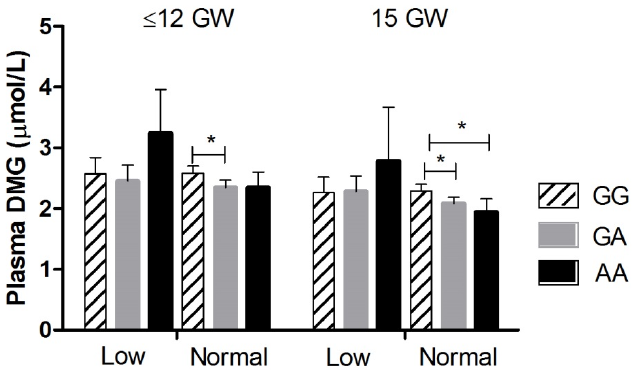
Figure 2. Plasma dimethylglycine according to BHMT c.716G>A genotype and folate status in early pregnancy. G: guanosine; A: adenosine; GW: Gestational weeks. Low: possibly deficient (plasma folate ≤ 13.4 nmol/L). Normal: normal-high (plasma folate > 13.4 nmol/L). At ≤ 12 GW, Low: GG